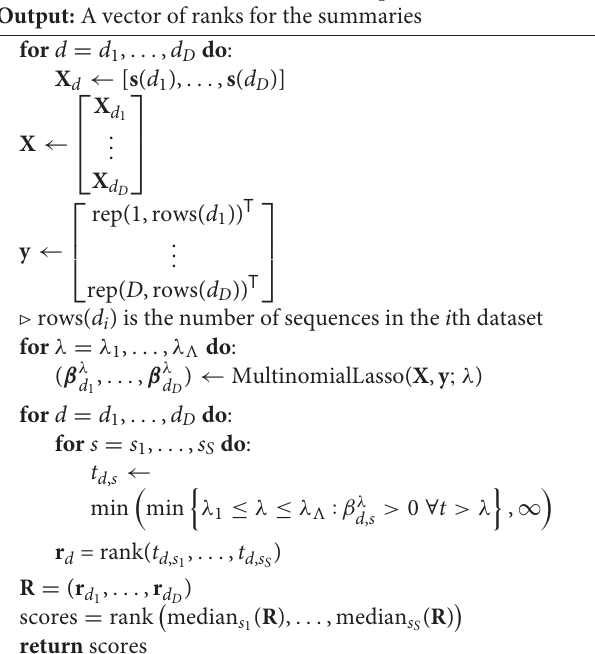
Algorithm 2: Compute automatic approximate nearest neighbor distance distribution